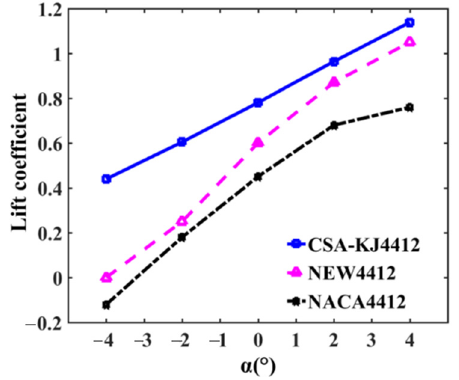
Figure 5. Comparison of lift coefficient.